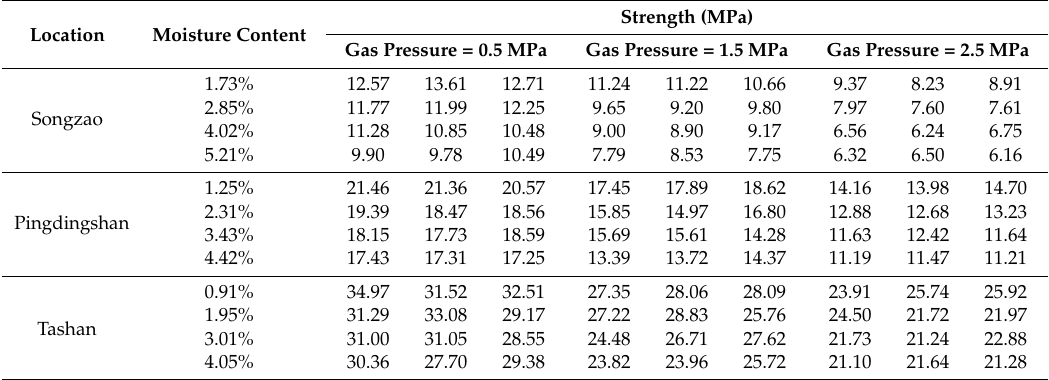
Table 4. Experimental scheme and recorded data for triaxial compression strength tests.